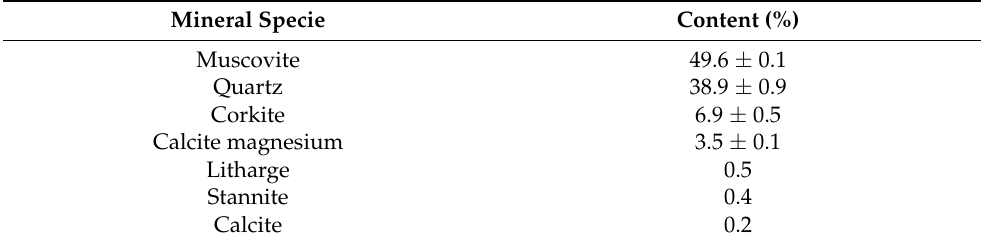
Table 1. XRD analysis of RD sample.